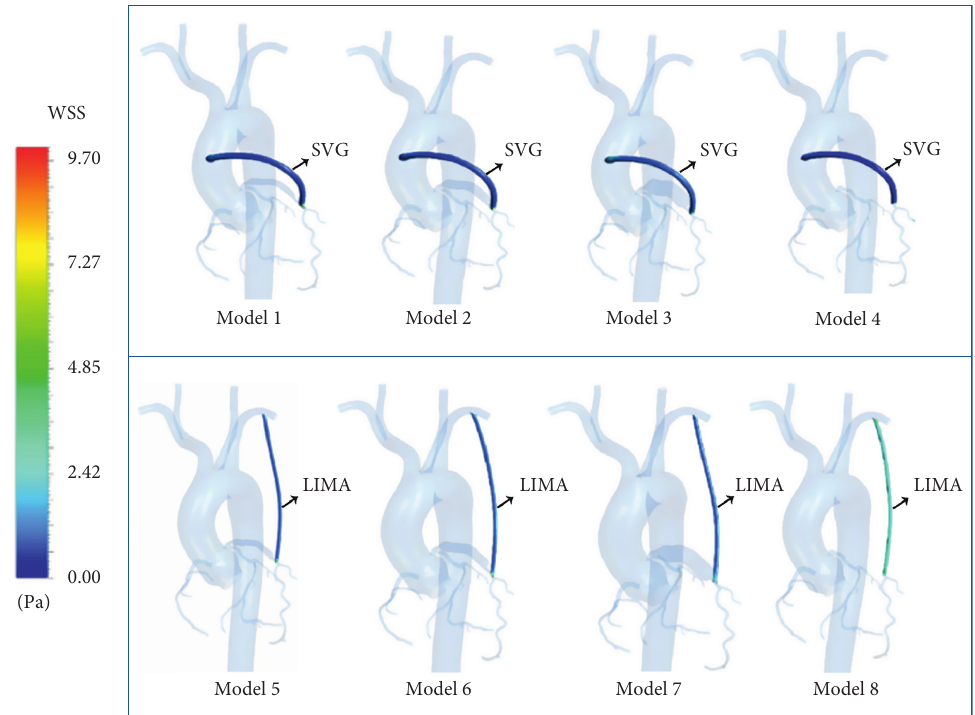
Figure 5: The WSS distribution on the bypass grafts (SVG and LIMA) at the peak point ( t � 0.24s) in a cardiac